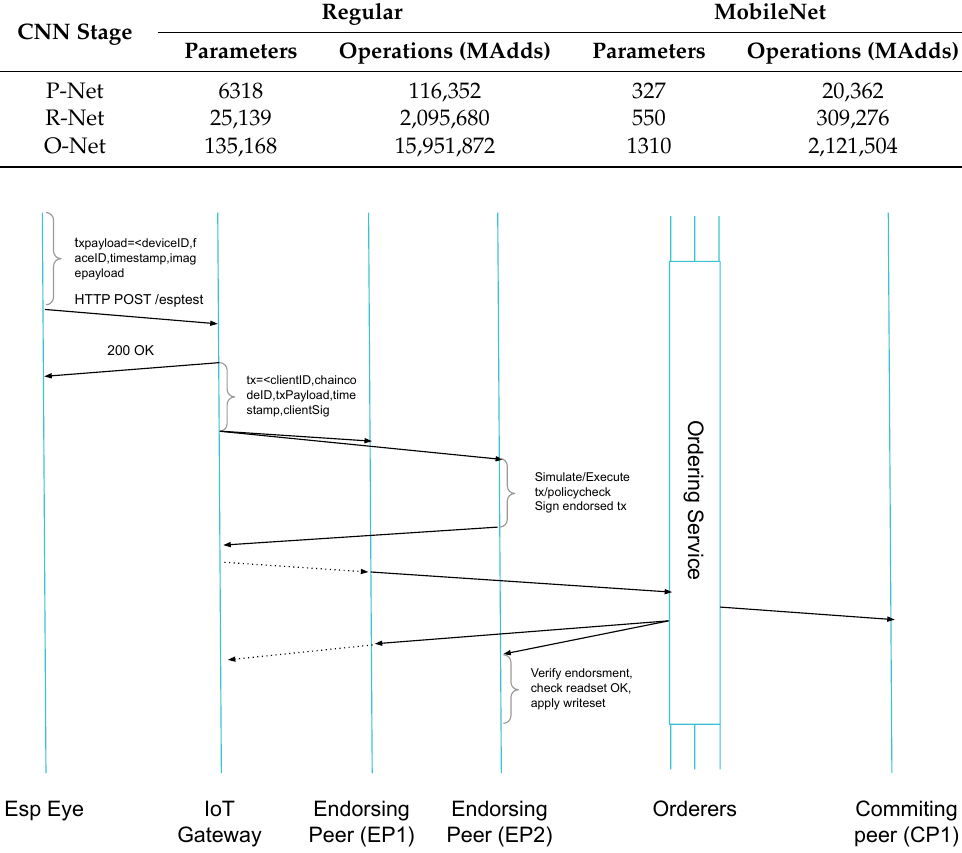
Figure 5. Sequence Diagram Showing TX